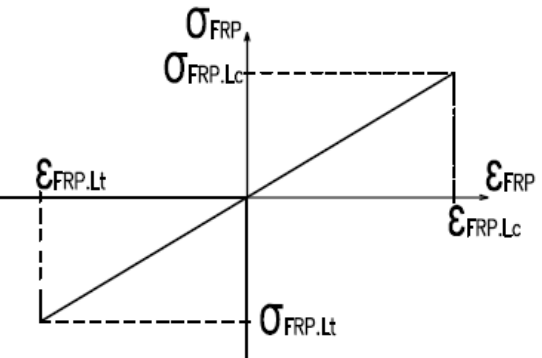
Figure 4. Stress–strain diagram for FRP.